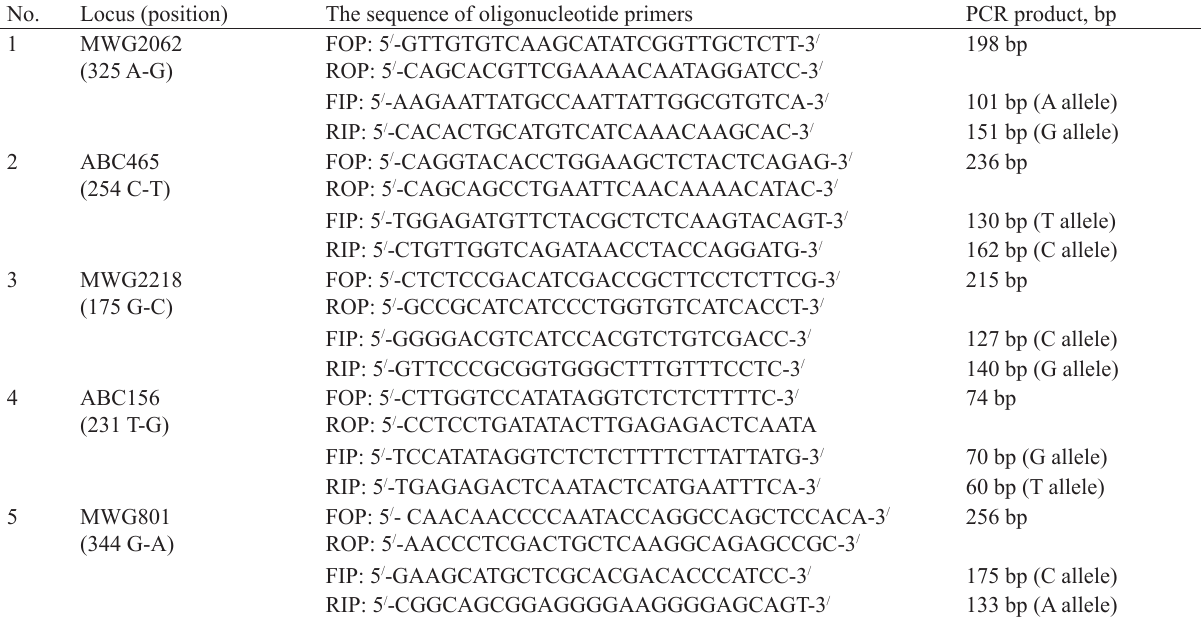
Table 4 SSR-markers of Hordeum vulgare nuclear DNA used for brewing barley varieties identification, potentially suitable for beer DNA